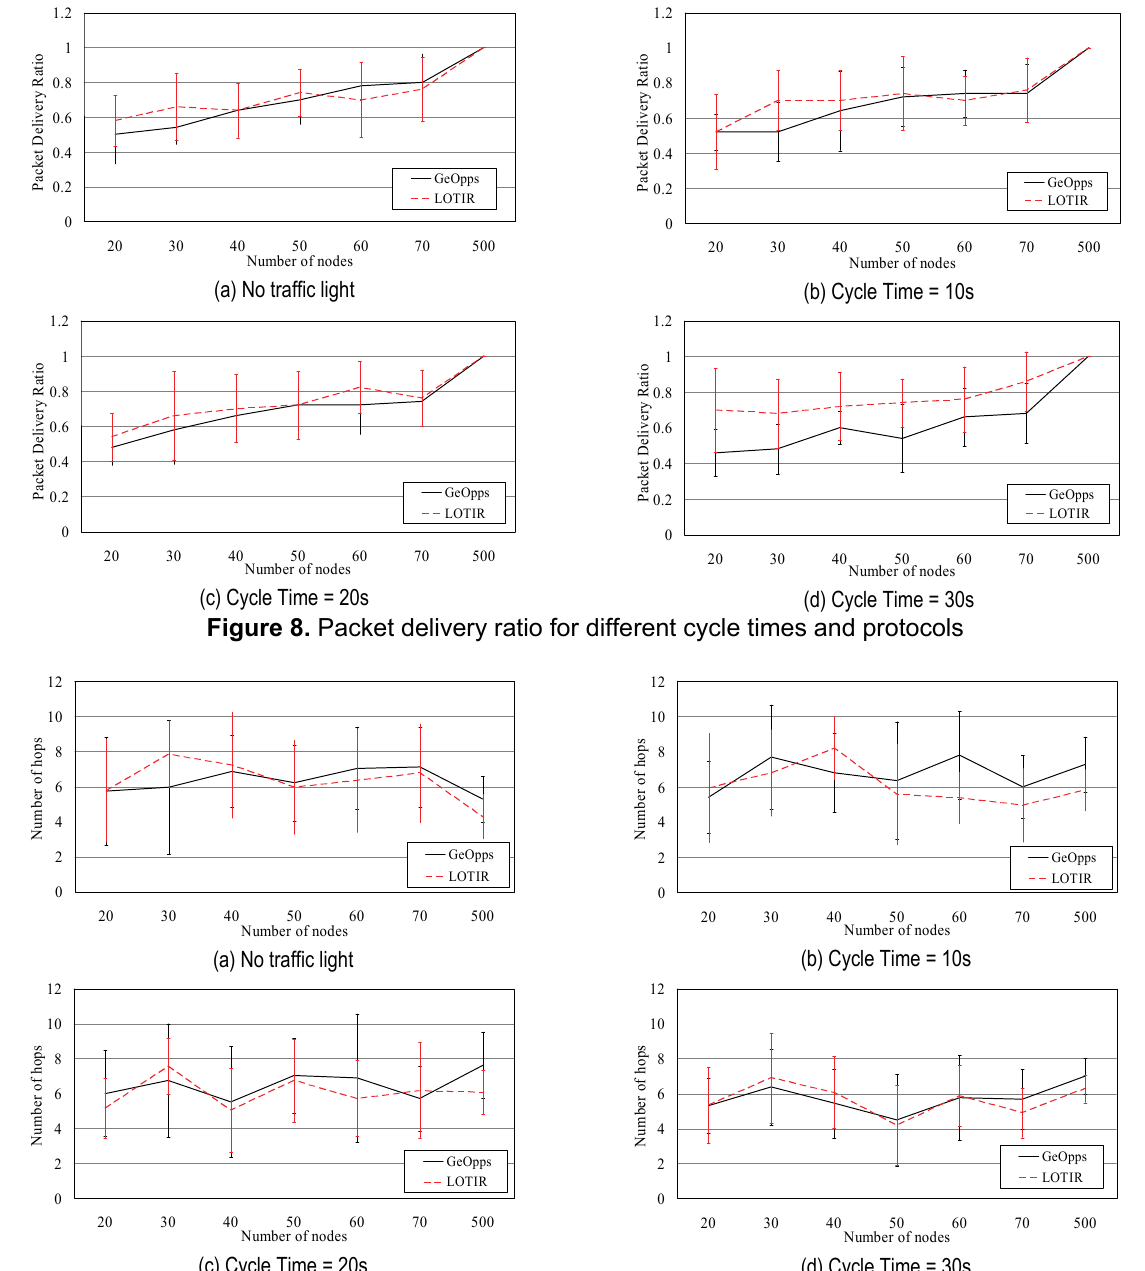
Figure 9. Number of hops for different cycle times and